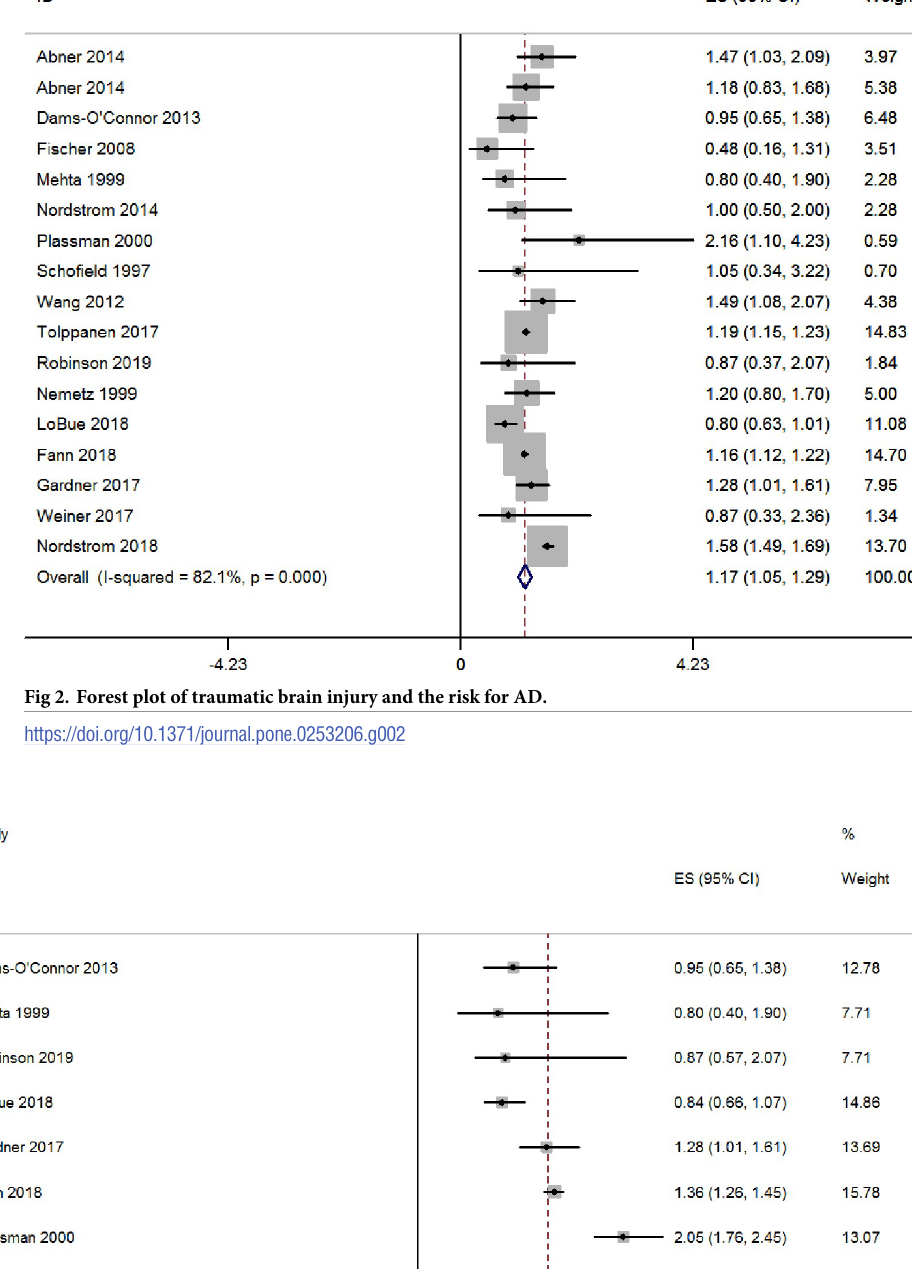
PLOS ONE | https://doi.org/10.1371/journal.pone.0253206 June 22,